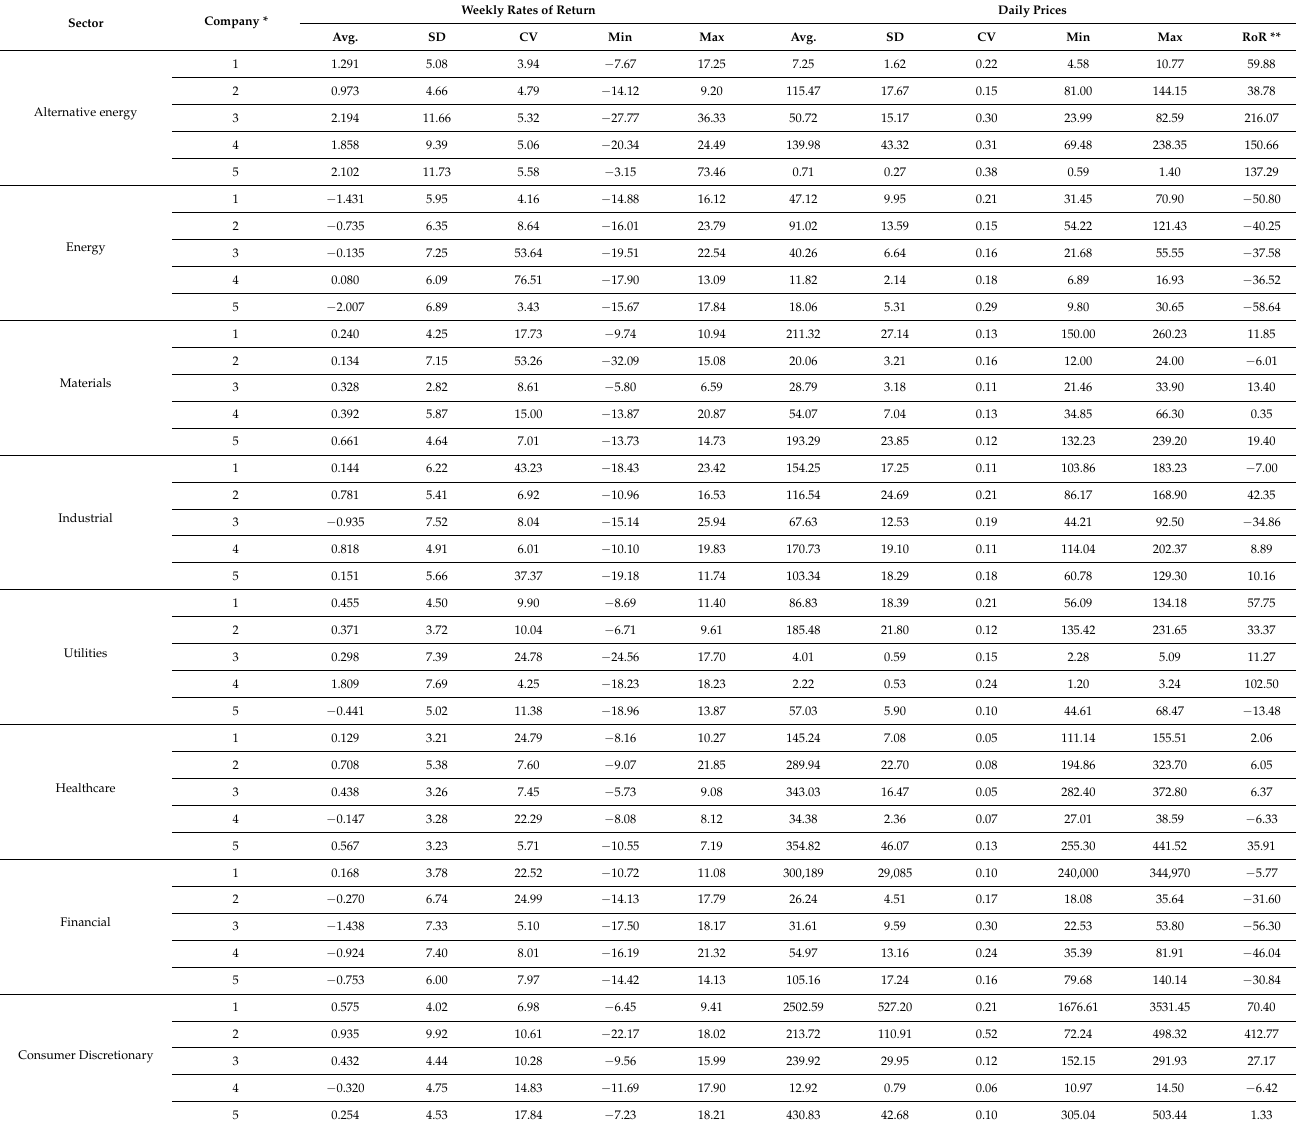
Table A4. Descriptive statistics for average weekly rates of return and daily prices: based on top five companies from stock market sectors. January–September